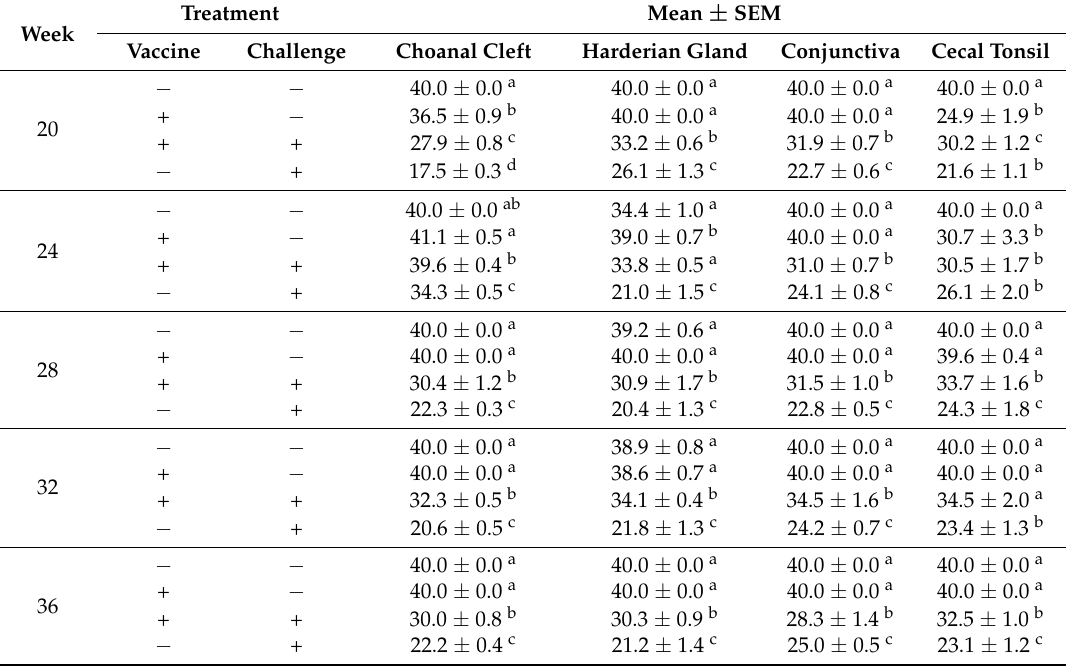
Table 1. Average quantitative reverse transcription polymerase chain reaction (qRT-PCR) cycle threshold (CT) values for infectious bronchitis virus (IBV) RNA collected from choanal cleft, Harderian gland, conjunctiva, and cecal tonsil 5 days post-challenge with IBV GA98 at 20, 24, 28, 32, and 36 weeks of age. Letters (a–d) indicate significant differences among vaccine and challenge groups for each week ( p < 0.05).